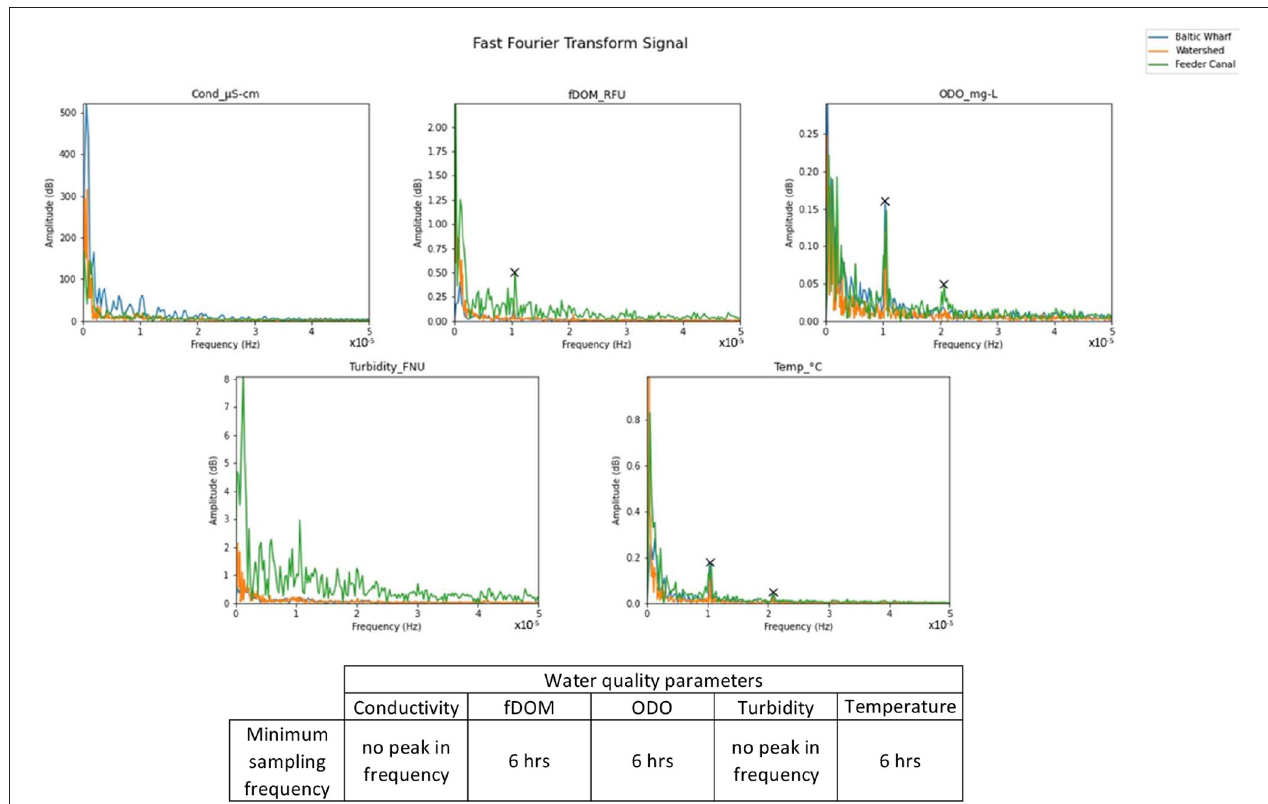
FIGURE 3 | Fast Fourier transform signal for the monitored parameters at 3 different locations. The marked peaks represent the minimum sampling frequencies. The values of the minimum sampling frequency marked on the plots are shown in the table.